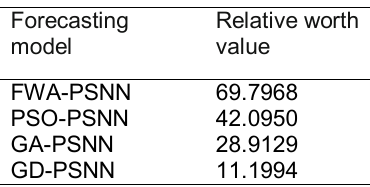
Table 5 . Relative worth values of forecasting